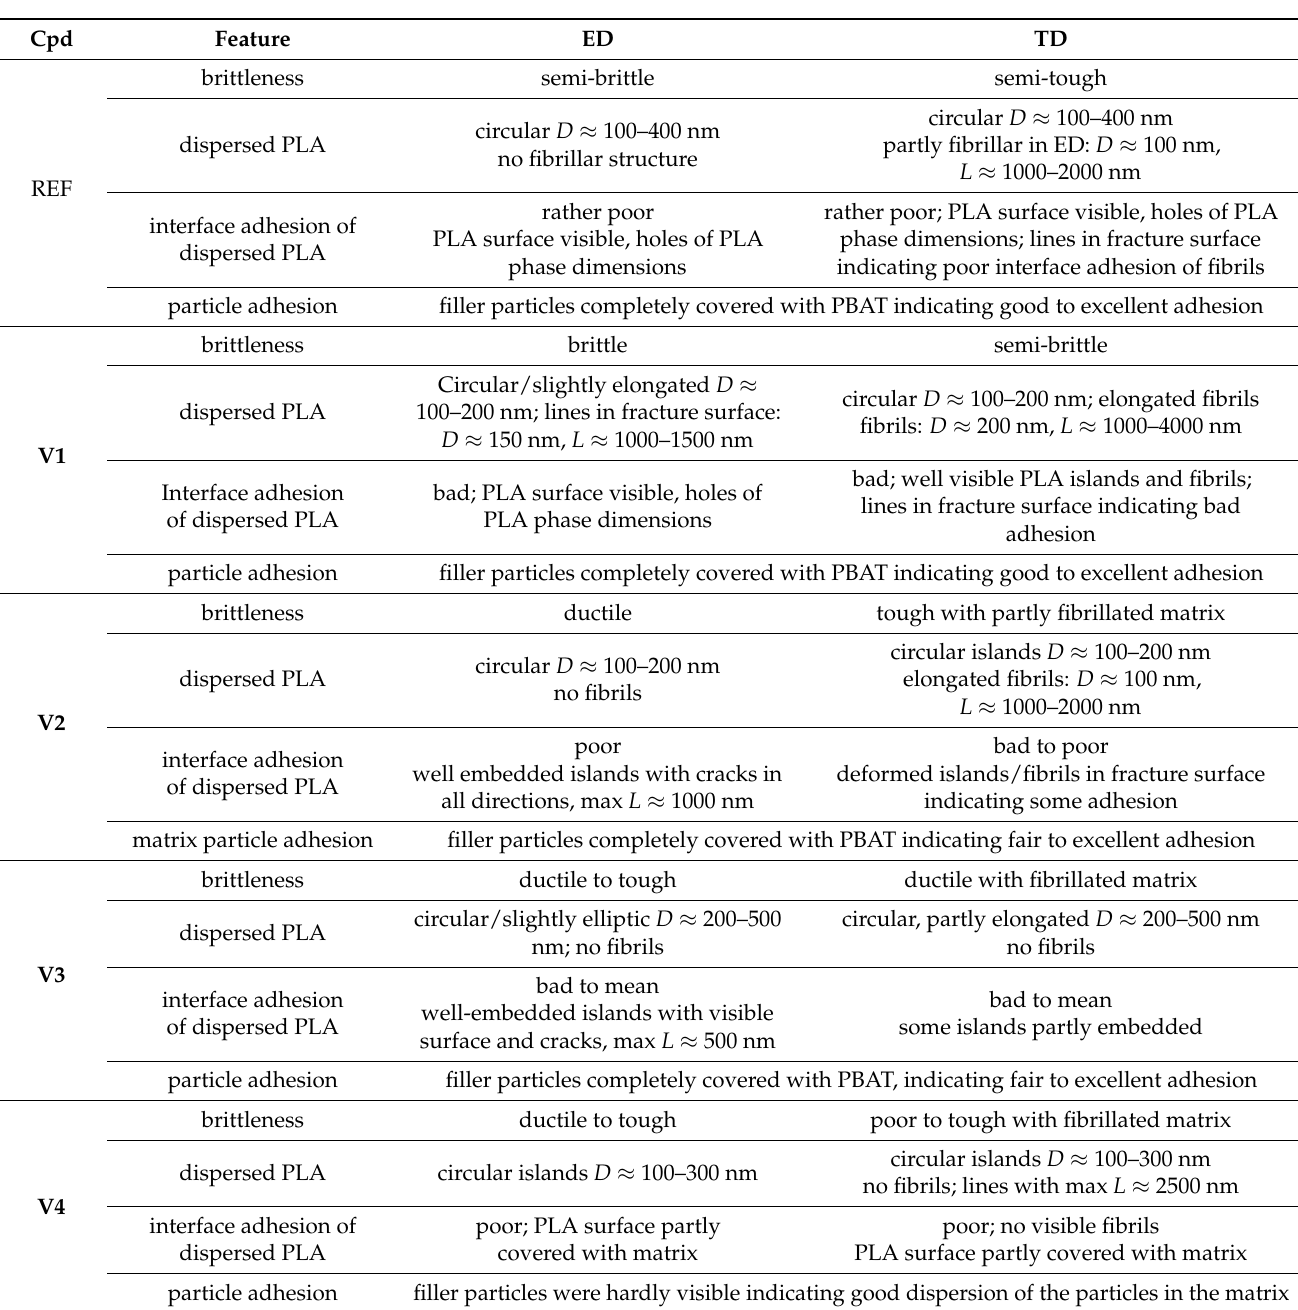
Table 1. Summary of structure features seen on fracture surfaces of unmodified PBAT/PLA (REF) and CECL-modified (V1 to V4) films in ED and TD blown molding